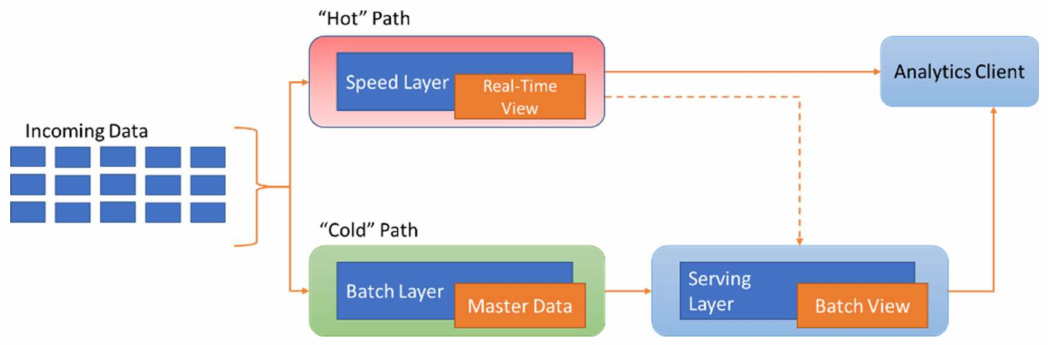
Figure 5. Three layers of the Lambda